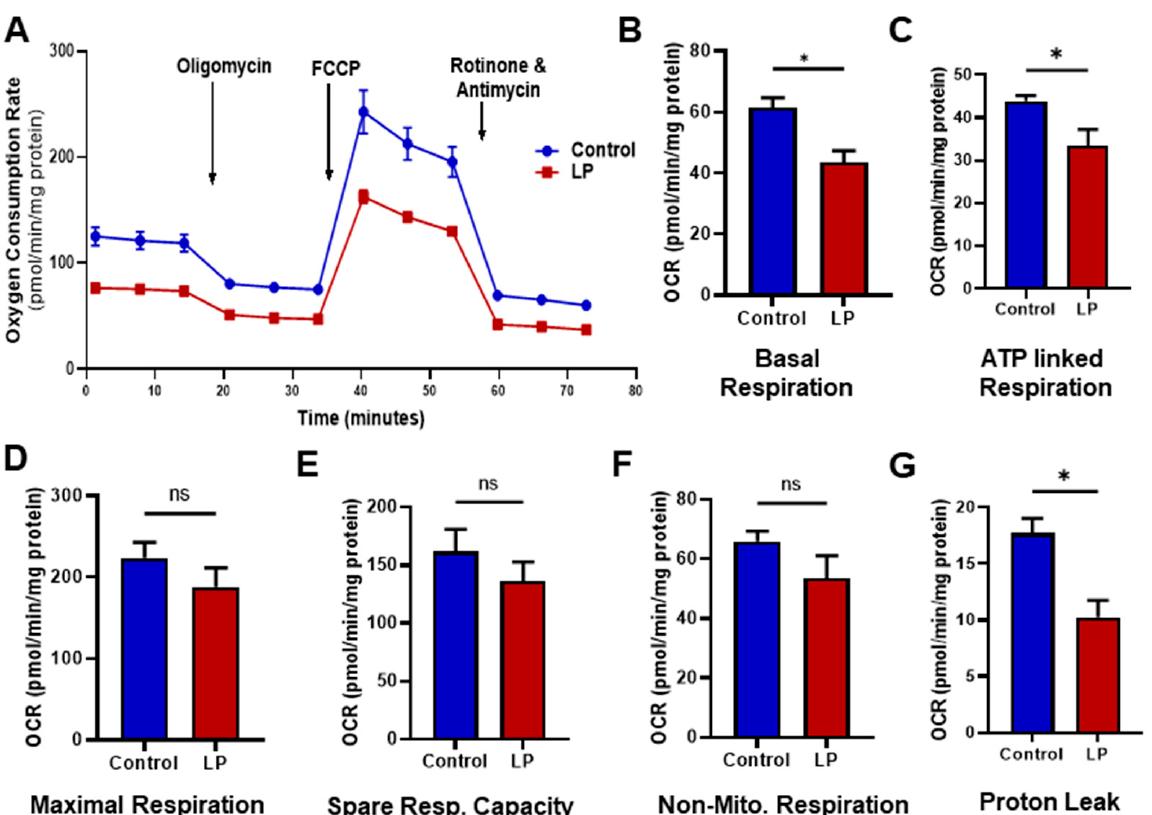
Figure 2. Effects of LP programming on the mitochondrial oxygen consumption rate (OCR) in the control vs. LP hepatocytes. The OCR measured before the addition of inhibitors was basal respiration. The arrows indicate the exact time at which different inhibitor compounds were injected into the wells: ( A ) representative image of normalized mitochondrial oxygen consumption rates; control (blue) vs. LP (red); ( B ) basal respiration; ( C ) ATP linked respiration; ( D ) maximal respiration; ( E ) spare respiratory capacity; ( F ) non-mitochondrial respiration; ( G ) proton leak. Data represent mean ± SEM (* p < 0.05, ns—not significant); n = 4 in control and n = 6 in LP. Four replicates were used for each animal. FCCP: carbonyl cyanide 4-(trifluoromethoxy)phenylhydrazone.